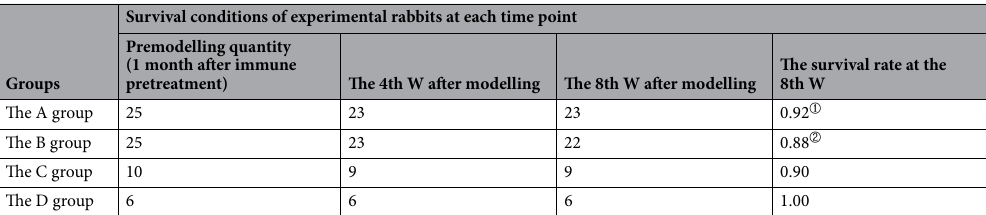
Table 2. Survival status of experimental rabbits in each group after modelling establishment. Compare ① and ② , P > 0.05.